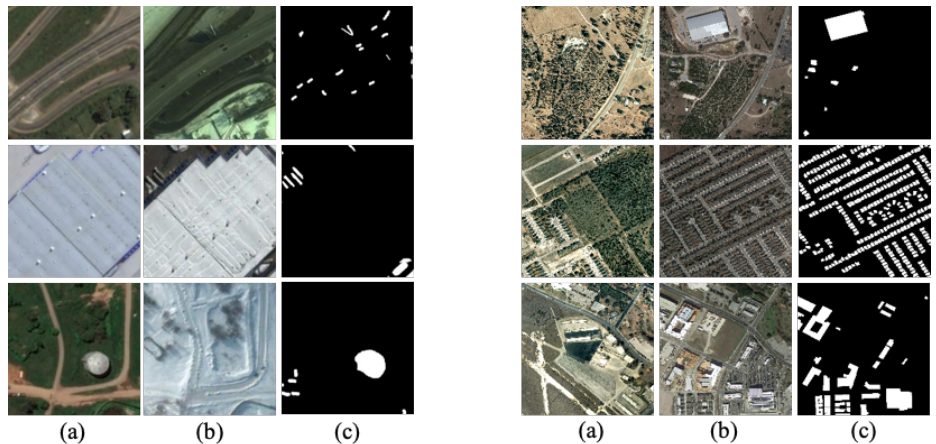
Figure 7. The left images are selected from the CDD dataset, and the changes are man-made. The right images are selected from the LEVIR-CD dataset, and most changes are caused by the addition of new buildings: ( a ) prechange, ( b ) postchange, and ( c ) ground